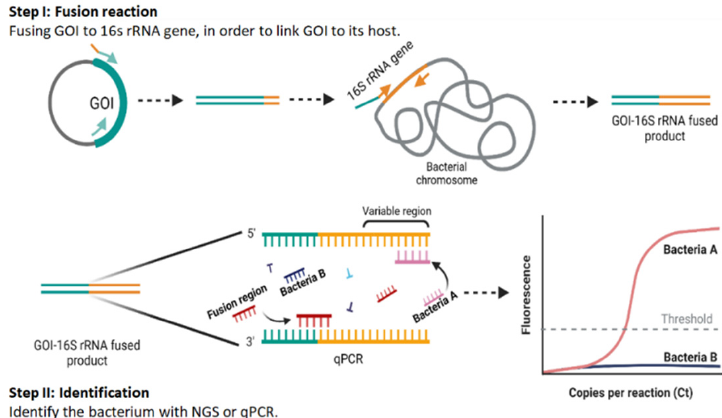
Figure A5. Illustration of the two steps of the OIL PCR method.